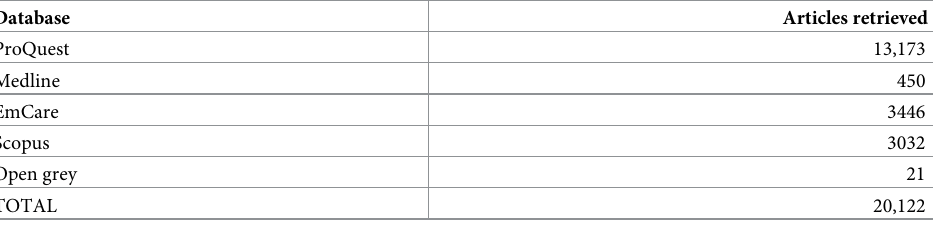
Table 2. Electronic database search